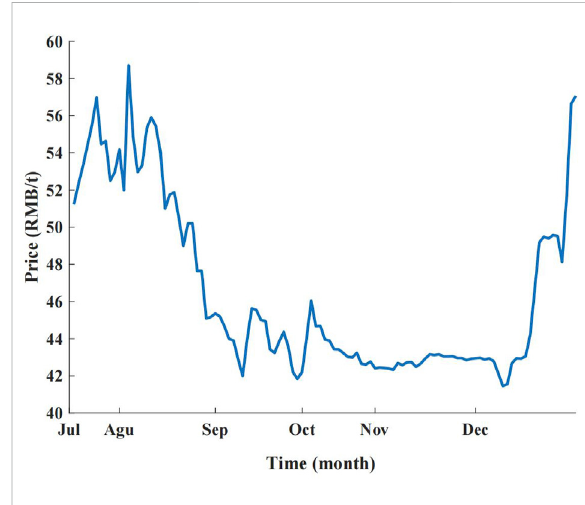
FIGURE 3 The carbon price of the national carbon market in China.